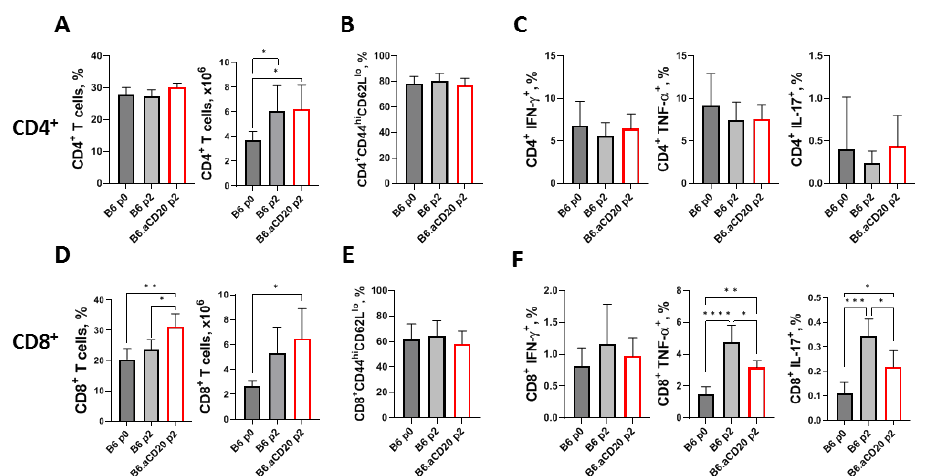
Figure 3. B-cell depletion alters the influx and cytokine production by CD8 + but not CD4 + T cells. Frequencies and numbers of CD4 + ( A ) and CD8 + ( D ) T cells in the lungs of B-cell-depleted and control mice. Frequency of activated CD4 + CD44 hi CD62L lo ( B ) and CD8 + CD44 hi CD62L lo ( E ) T cells in the lungs before and 30 days after anti-CD20 treatment measured by flow cytometry. Intracellular